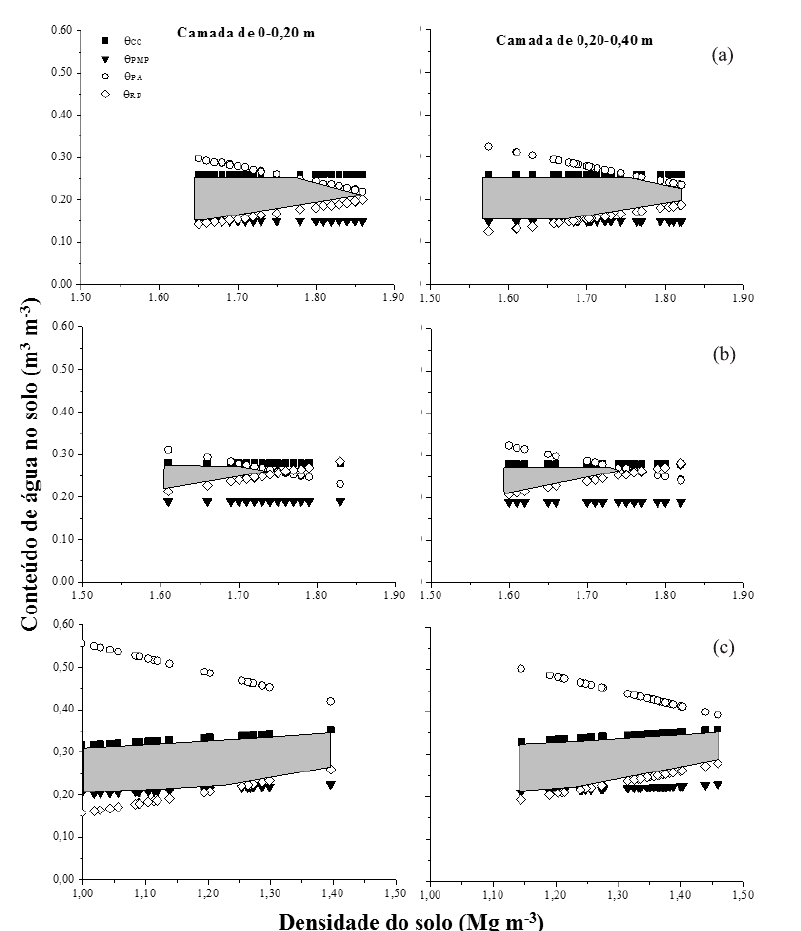
Figura 2. Conteúdo de água no solo ( θθθθθ ) em função da densidade do solo no PVA arenoso (a), no LV textura média (b) e no LV argiloso (c), nos valores críticos de capacidade de campo ( θθθθθ permanente ( θθθθθ ), porosidade de aeração 0,10 m 3 m -3 ( θθθθθ pmp área hachurada representa o Intervalo Hídrico Ótimo